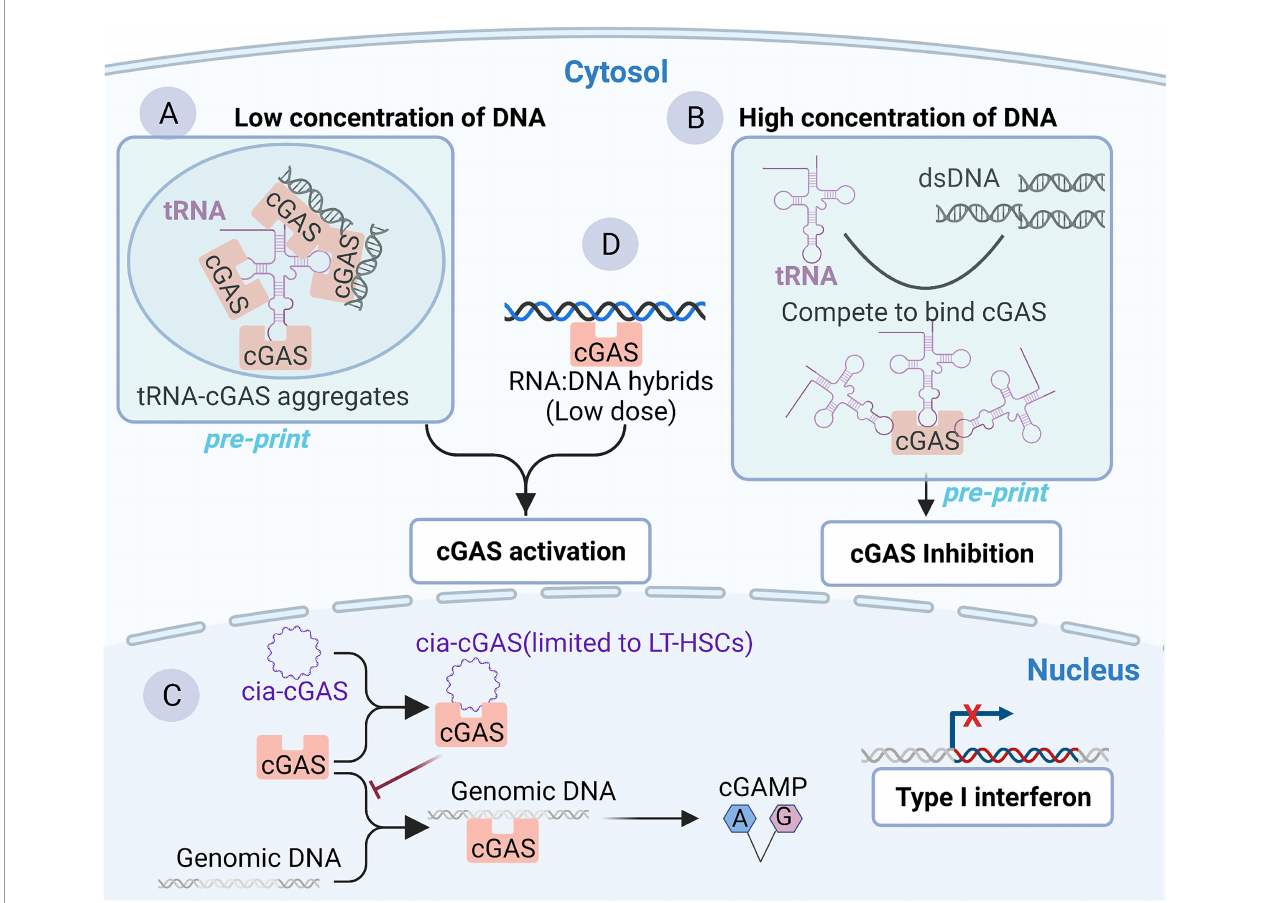
FIGURE 2 | Binding of cGAS to RNA or RNA: DNA hybrids. (A, B) Binding of cGAS to tRNA as reported by a preprint server, which remains to be fully supported experimentally in cells. Cytoplasmic tRNA regulates cGAS activity by interfering with the formation of cGAS-containing aggregates. (A) In the context of low concentrations of DNA, cytoplasmic tRNA forms aggregates with cGAS, providing a platform for dsDNA-mediated cGAS activation. (B) In the context of a high concentration of DNA in the cytoplasm, DNA is suf fi cient to induce phase separation and activate cGAS. However, tRNA harbors a higher af fi nity than dsDNA for cGAS. Consequently, cGAS competes with dsDNA to bind cGAS and inhibit cGAS activity to avoid an excessive immune response. (C) Binding of cGAS to cia- cGAS. A circular RNA named cia-cGAS was highly expressed in the nucleus of LT-HSCs. Under homeostatic conditions, cia-cGAS binds cGAS in the nucleus to inhibit its binding to genomic DNA. As a consequence, cia-cGAS suppressed cGAS-mediated production of type I IFNs, thereby protecting dormant LT-HSCs from cGAS-mediated exhaustion. (D) RNA : DNA hybridization products can bind and activate